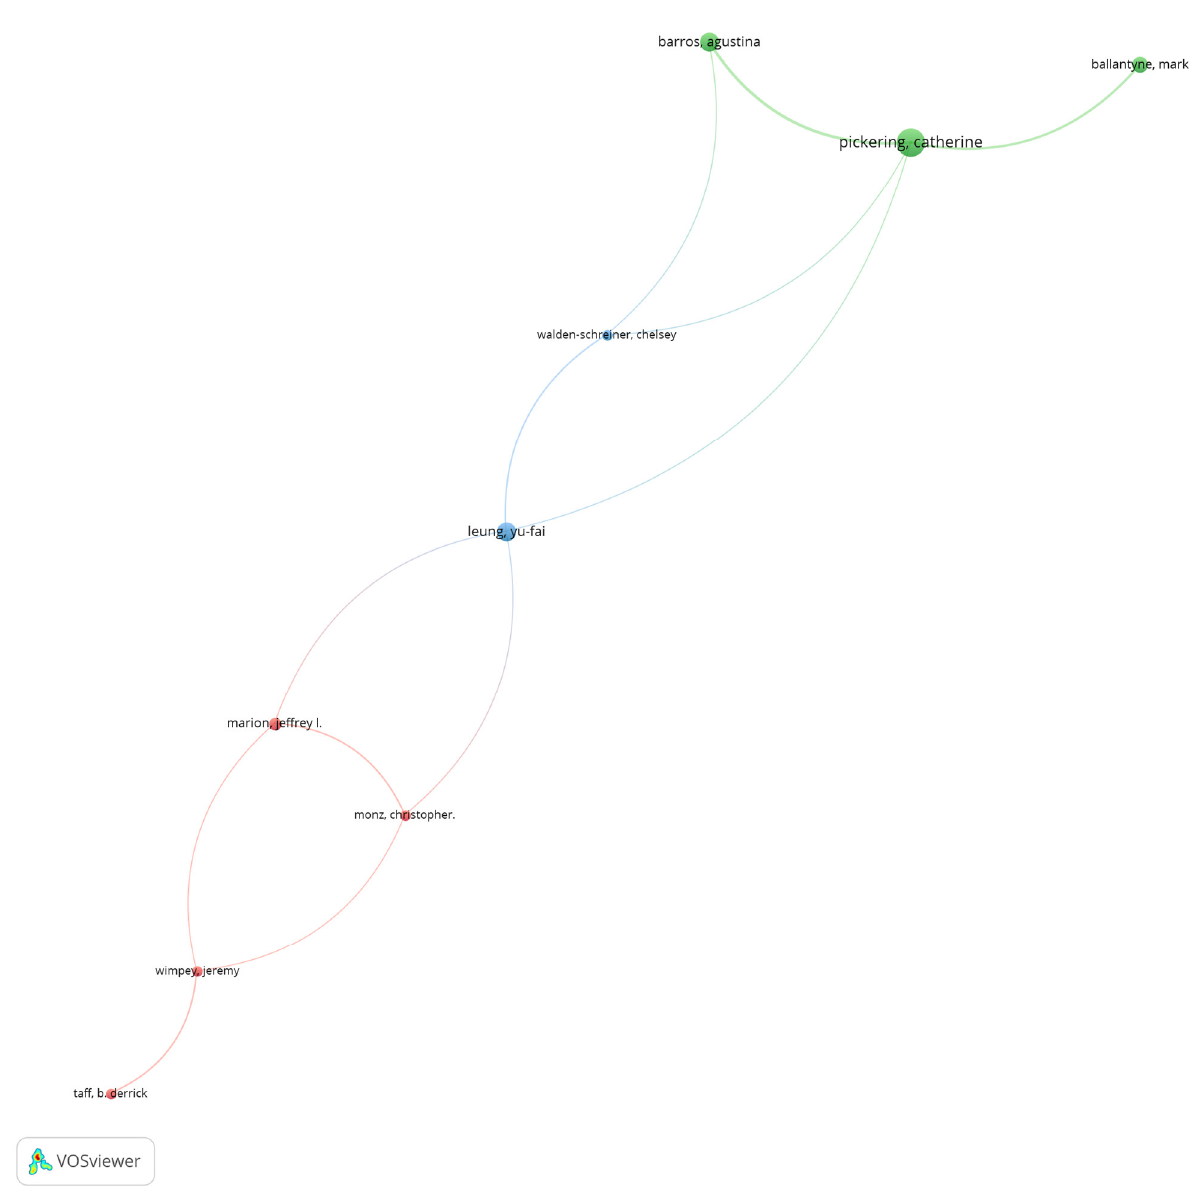
Figure 3. Bibliographic data map of co-authorship analysis (based on authors).